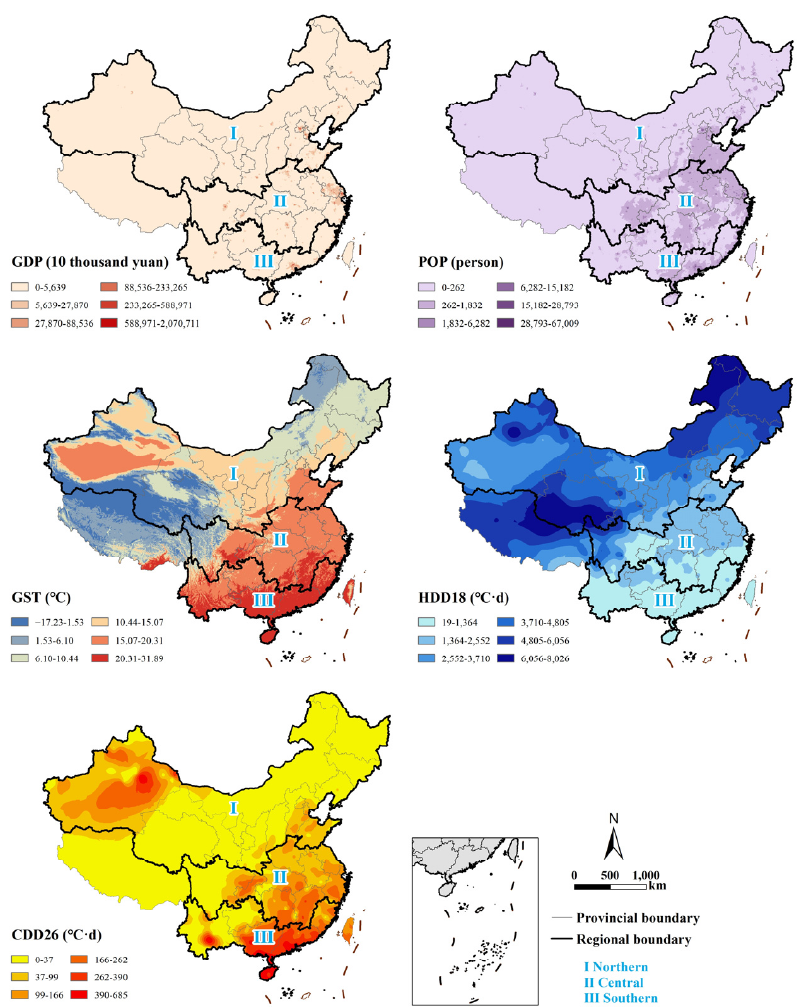
Figure 3. Spatial distribution of GDP, POP, GST, HDD18, and CDD26 of China in 2015.